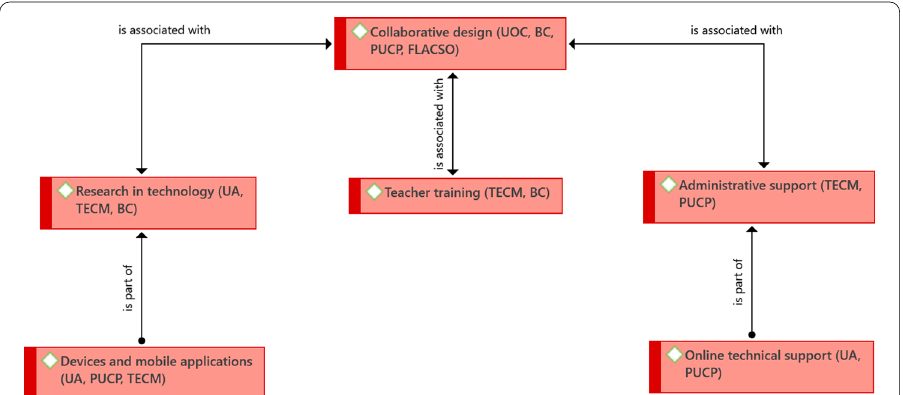
Fig. 7 Structure of driving ideas associated with shared key success factors in technology. Source: Diógenes